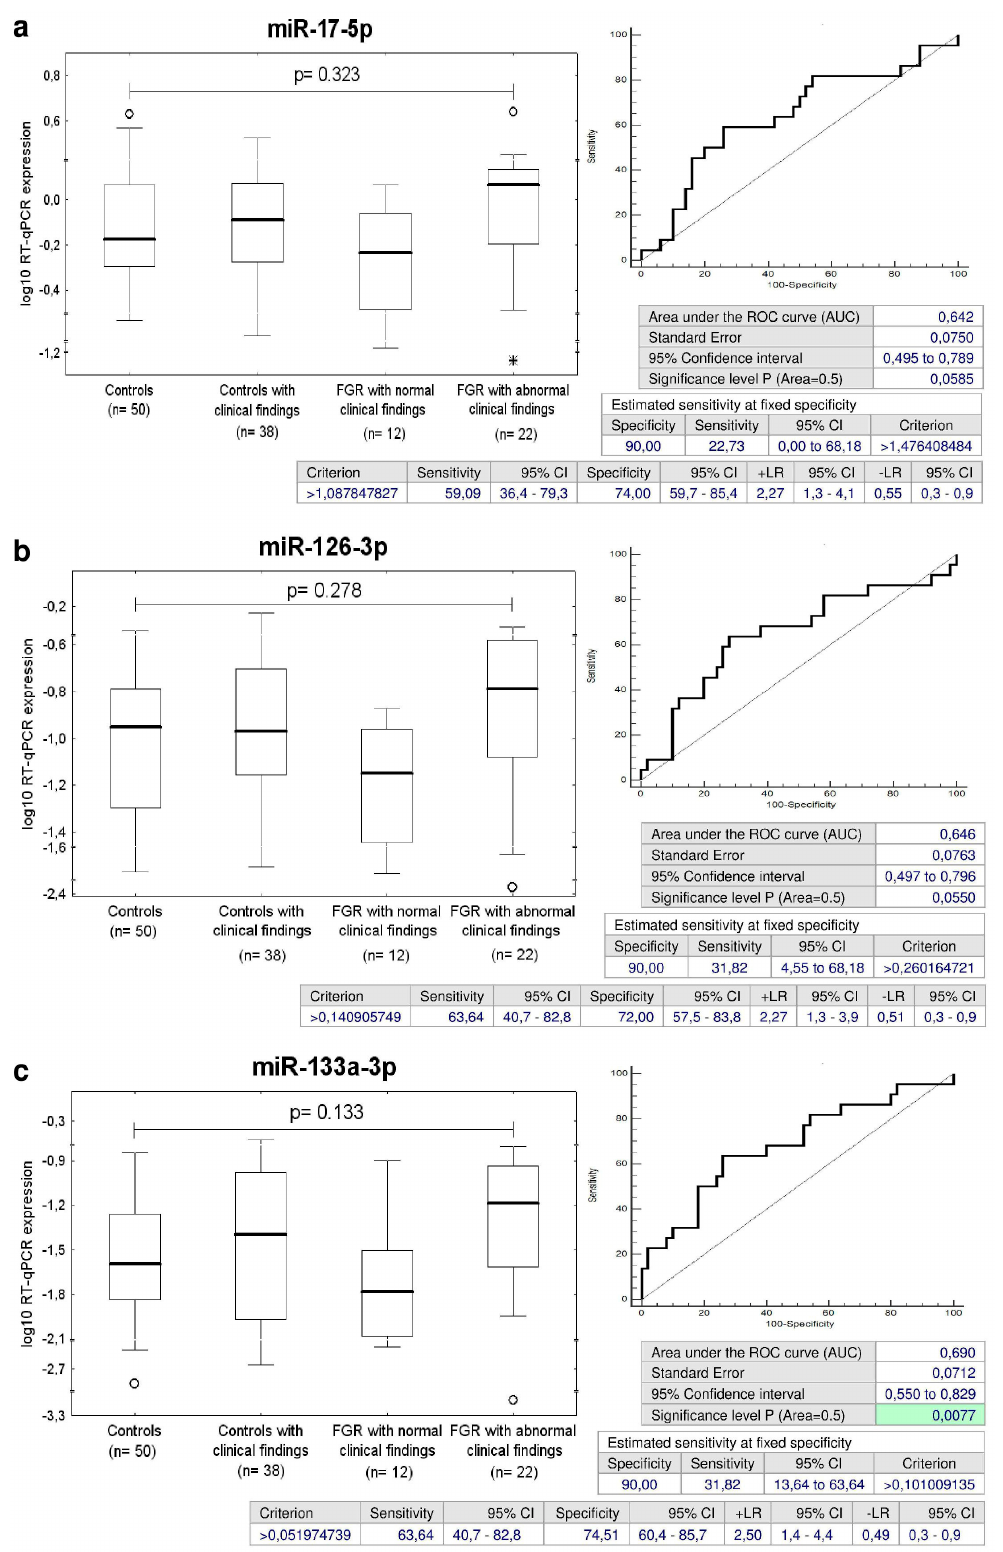
Figure 15. Postnatal microRNA expression profile in children with abnormal postnatal clinical findings descending from FGR pregnancies. ( a – c ) Increased expression of miR-17-5p, miR-126-3p, and miR-133a-3p was observed in children with abnormal postnatal clinical findings descending from FGR pregnancies.